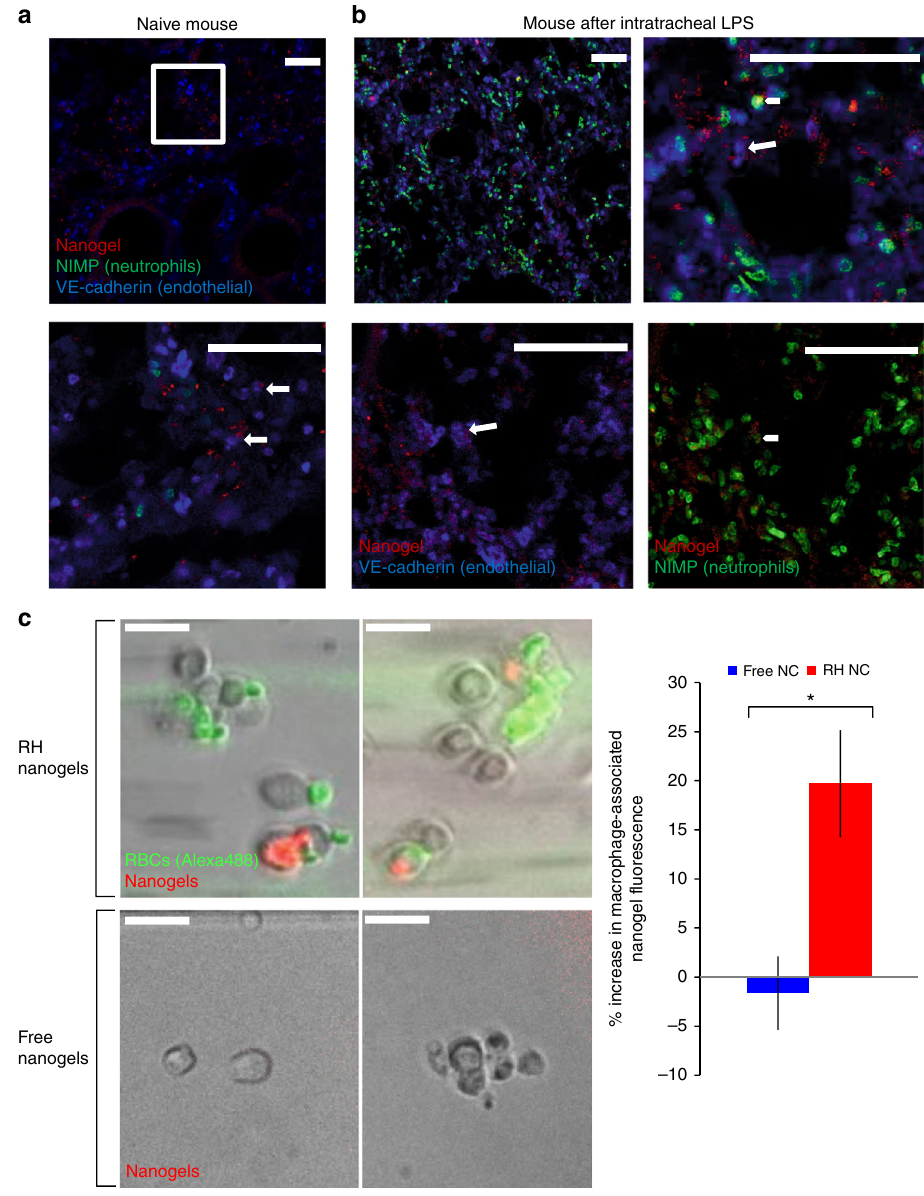
Fig. 3 RH NCs are taken up by endothelial cells and leukocytes of target organ capillaries. a Mice were IV injected with RH rhodamine-conjugated nanogels (NGs), sacri fi ced 30 min later, and then the lungs were fi xed and sectioned. The sections were stained with an endothelial marker (VE-cadherin, blue) and a leukocyte marker (NIMP, green). Rhodamine-NG fl uorescence localized to the capillary endothelial cells with small amounts of nanogel signal colocalizing with sparse leukocytes (top row 10×, bottom row 40×). Thick white lines represent scale bars of 100 µ m. b Mice were given intratracheal LPS to model ARDS prior to RH NCs injection as in a . The top left panel is a 10× image, while the top right is a 40× magni fi cation plus digital zoom of the same region. As seen in the top left image, red nanogels are present in an overlapping distribution with both endothelial cells (blue) and leukocytes (green). The two bottom panels are 40× images of another region of the tissue, but displaying only two markers each for ease of viewing. Thick white lines represent scale bars of 100 µ m. c Macrophages were plated in fl ow chambers and NGs (labeled red) were introduced, either free or adsorbed onto RBCs (labeled green). As seen in two separate experiments using RH NGs (top two panels), the RH NGs (red) localize to the center of the macrophages, and the RBCs (green) transiently localize on the periphery of the macrophages. In two other experiments using free NGs (bottom two panels), very little NG signal localizes with the macrophages. Scale bars represent 20 μ m. In the rightmost panel, we have quanti fi ed the gain in macrophage-co-localized red fl uorescence (corresponding to nanogels) during the course (10 min) of each of these experiments. Each data point represents mean ± s.e.m ( n = 4 for free NG, n = 12 for RH NGs); * P < 0.05, non-paired, two-tailed t ARDS, intratracheal LPS. LPS markedly increased the leukocytes (Fig. 4h, left panel) and edema-related protein in the alveoli RH nanogels and negative controls (Fig. 4g). (Fig. 4h, right panel), but the addition of RH did not lead to any change in these sensitive in fl ammatory markers.